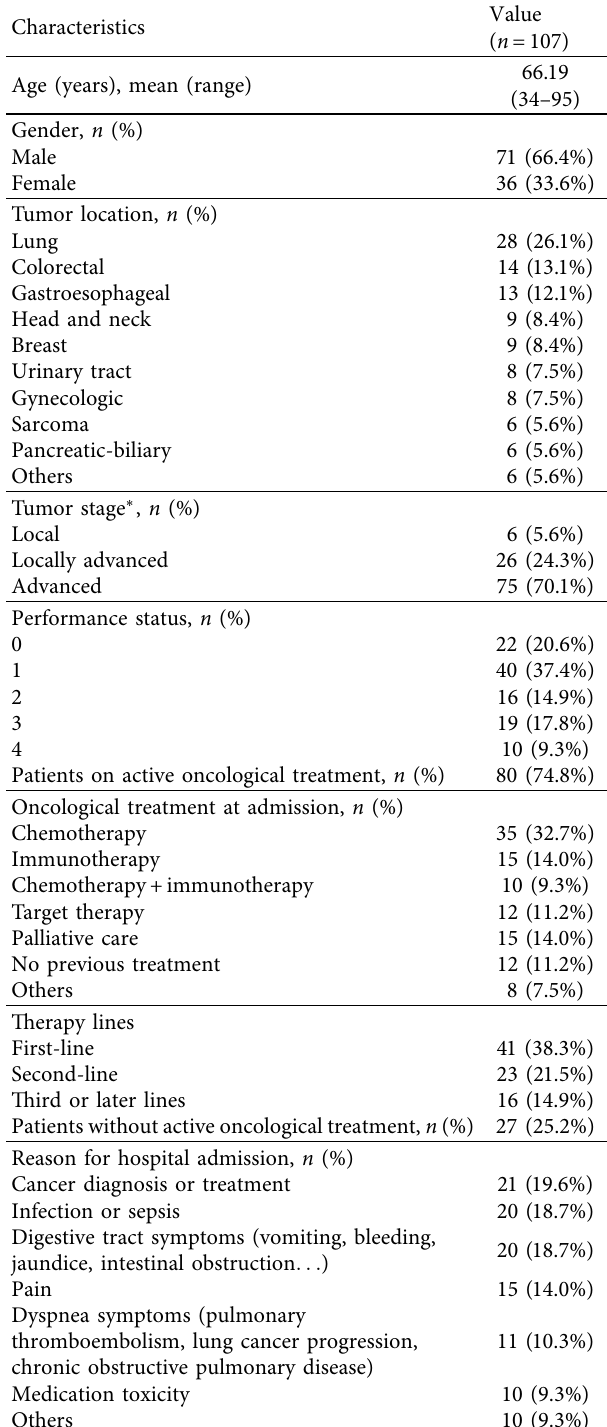
Table 1: Patients’ characteristics at hospital admission (study population,